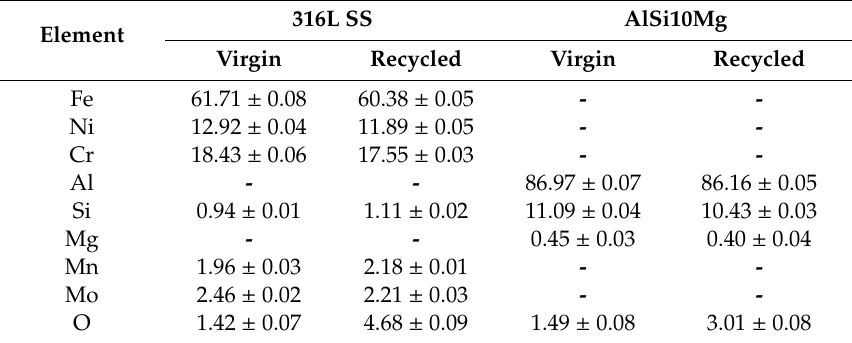
Table 2. Chemical composition of virgin and recycled powders via electron-dispersive X-ray spectroscopy (EDX) analysis (wt.%).